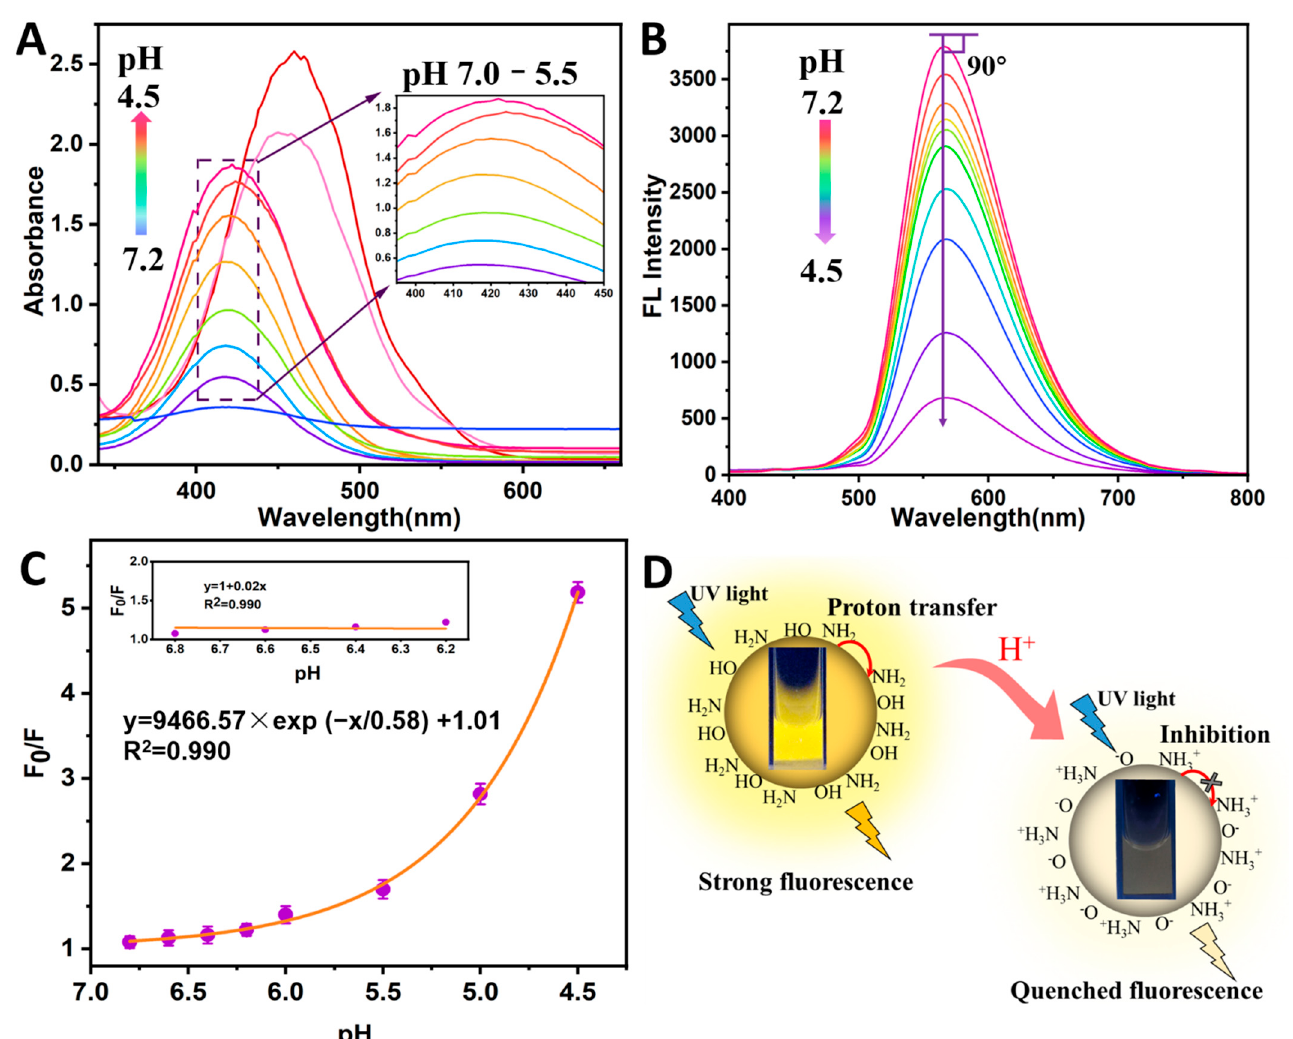
Figure 4. ( A ) UV-vis absorption spectra of N-CQDs solution at different pH values (4.5, 5, 5.5, 6, 6.2, 6.4, 6.6, 6.8, 7.0, and 7.2); ( B ) Fluorescence spectra of N-CQDs solution at different pH values; ( C ) Exponential fitting curve between F 0 /F and pH values (7.0-4.5), inset: linear curve between F 0 /F and pH values (6.8-6.2), the error bars were equal to the standard deviation of three measurements; ( D ) Schematic illustration of fluorescence quenching of N-CQDs.